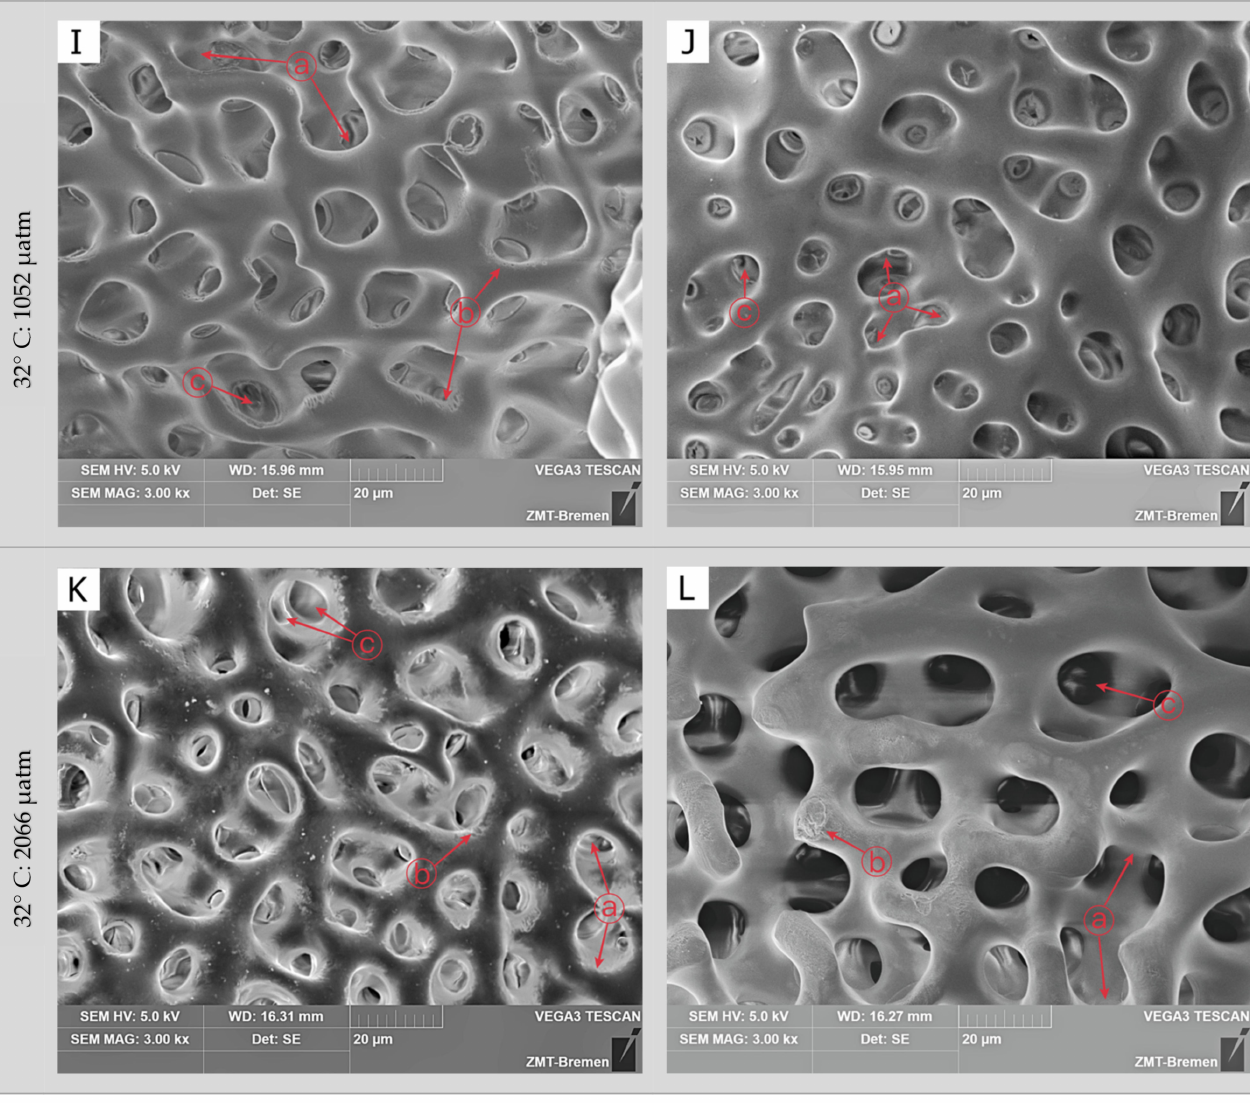
Figure 2. SEM micrographs of the skeletal microstructure of A. yairi cultured under two temper- ature levels (27 ◦ C and 32 ◦ C) crossed with three p CO 2 concentrations (455 µ atm, 1052 µ atm and 2066 µ atm). Stereom microstructure after 45 ( A , C , E , G , I , K ) and 90 days ( B , D , F , H , J , L ) of incubation (cid:108) time. sp : stereom pore; st : skeleton trabeculae; imp : stereom inner matrix pore; a the galleries (cid:108) (cid:108) stereom pores are less-equal in shape; b dissolution in calcium carbonate skeleton; c increased size of inner matrix aperture pores. Technical image acquisition, SEM mode: SE, SEM HV: 5.0 kV, SEM magnification: 3000 ×